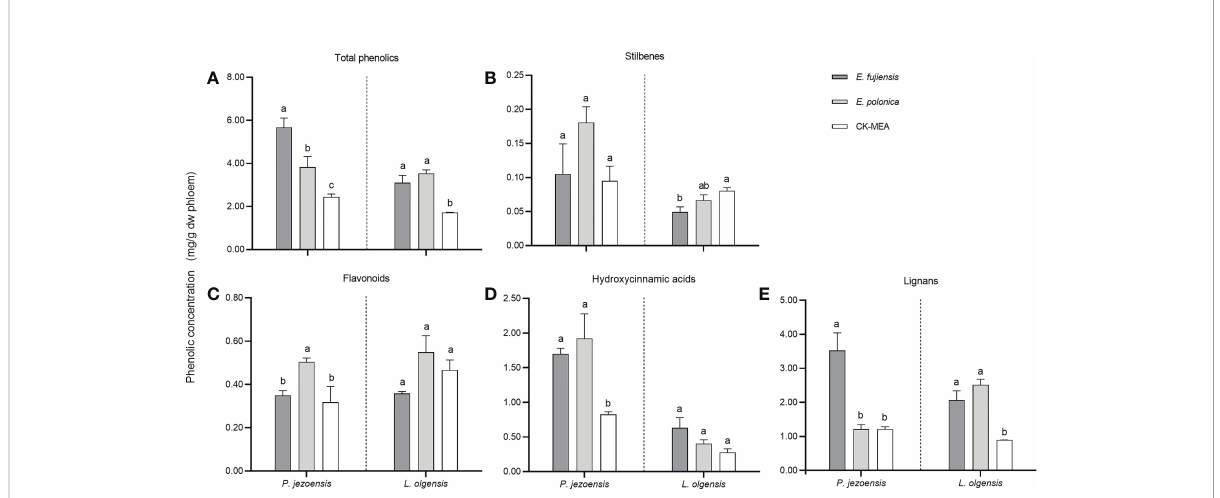
FIGURE 4 Mean (± SE) phenol concentrations (mg/g dw phloem) in the phloem of P. jezoensis and L. olgensis in response to culture inoculations. (A) Total phenols; (B – E) phenolic class stilbenes, fl avonoids, hydroxycinnamic acids, and lignans, respectively. Different letters in each graph indicate